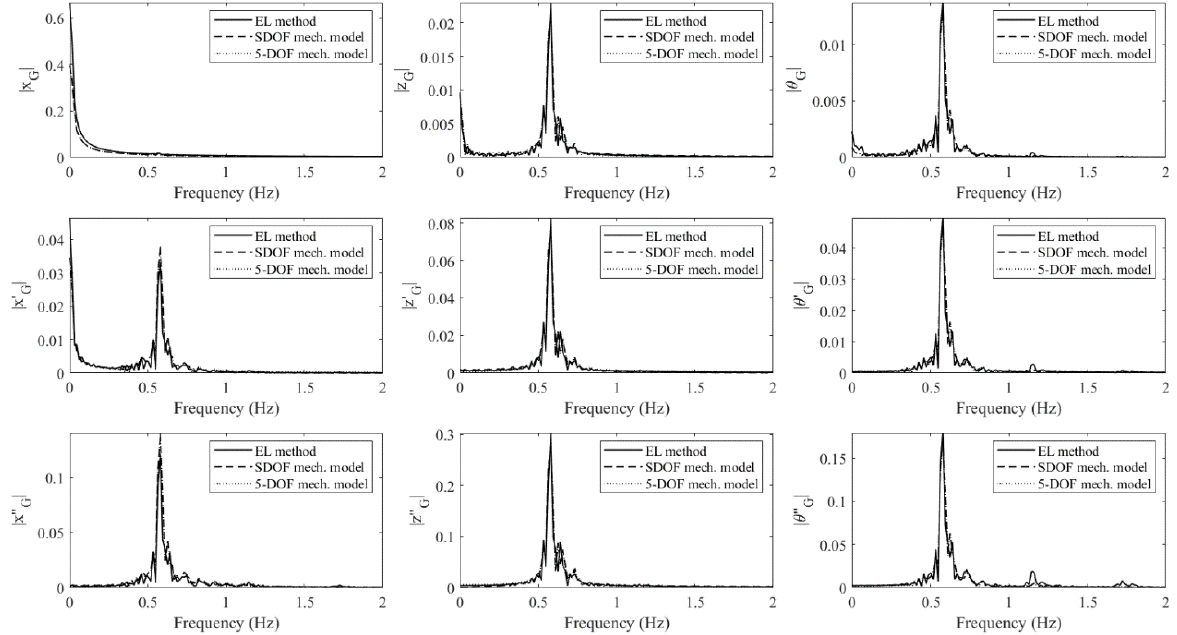
Figure 19. The overturning moments acting on the floating body for the small-wave case.